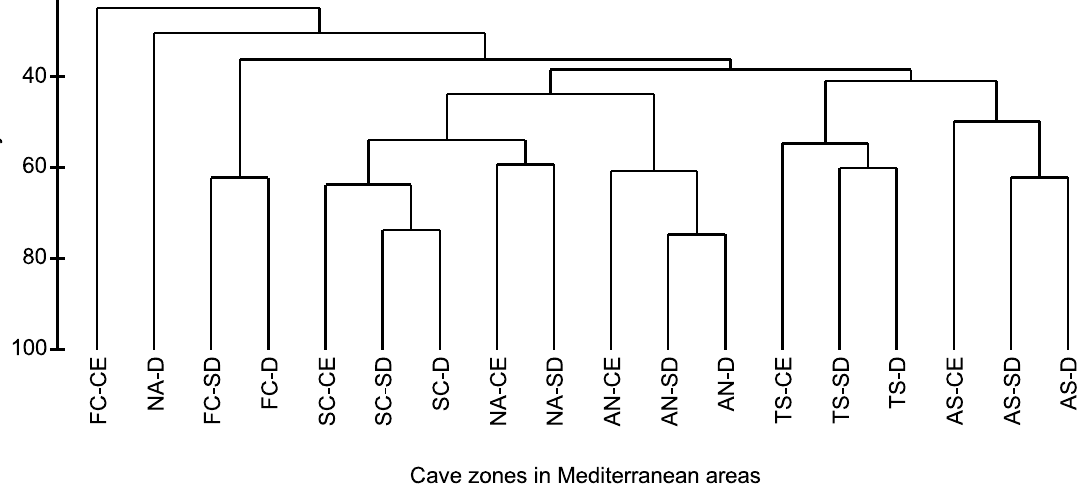
Figure 8. Resemblance of sponge assemblages from cave zones (entrance-CE, semidark-SD, dark-D) of Mediterranean subareas. For abbreviations of Mediterranean areas see Methods.